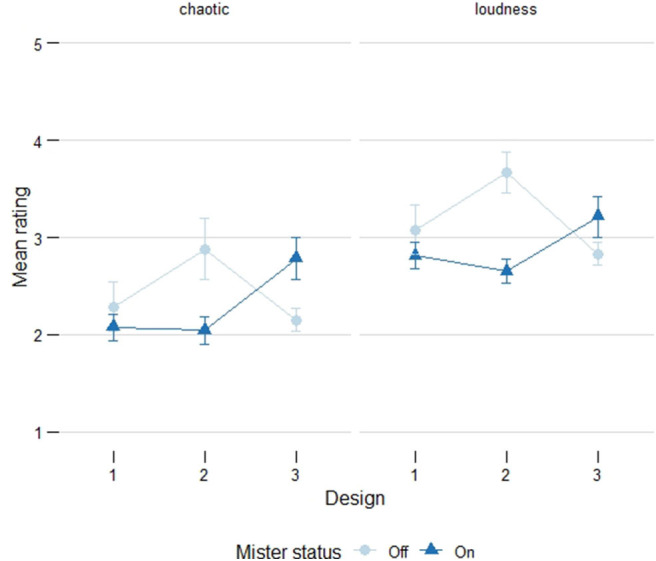
Mean values for the chaotic and loudness ratings. The x-axis indicates the design and the lines compare the status of the mister (off/on). Errorbars indicate the standard error. The mean rating for chaotic and loudness scales was lower when the mister was on during Designs 1 and 2, but they were higher for Design 3, indicating that the mister did not have a consistent effect across designs.